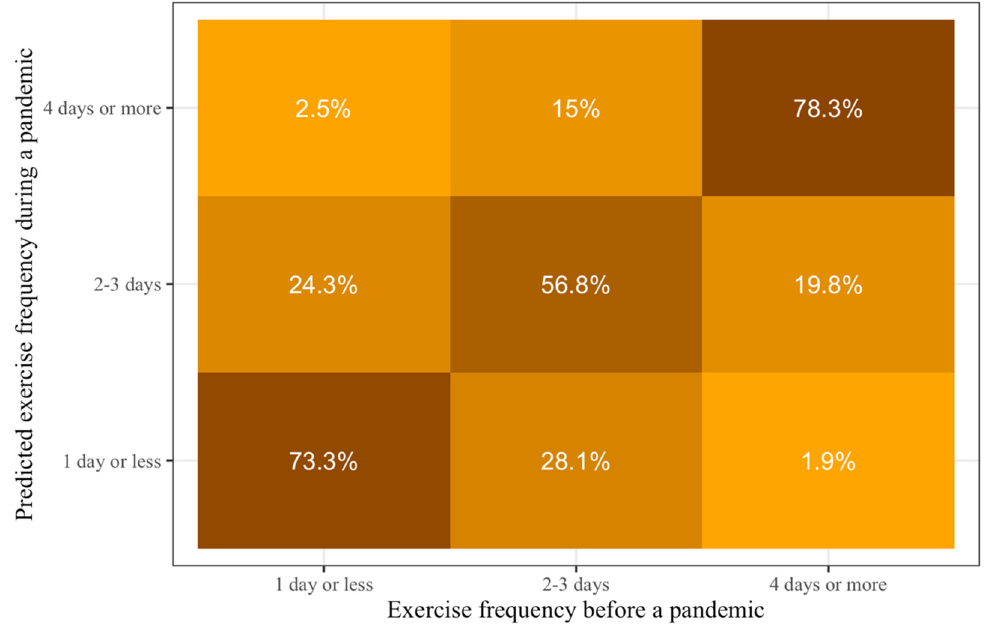
Figure 2. Predictions of probabilities of exercise frequency during conditions similar to COVID-19 pandemic based on prepandemic exercise frequency. Lighter colors show smaller probabilities and darker colors show larger probabilities. The darkest colors are all on the diagonal from the bottom left to the top right, which means that people who exercise at a specific frequency before such pandemics would be most likely to exercise at the same frequency during it.